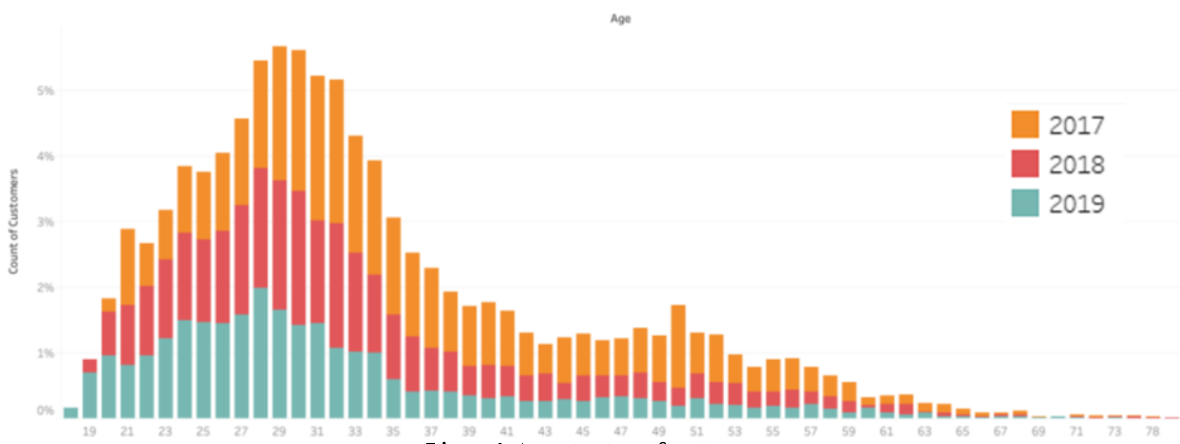
Figure 1. Age structure of customers